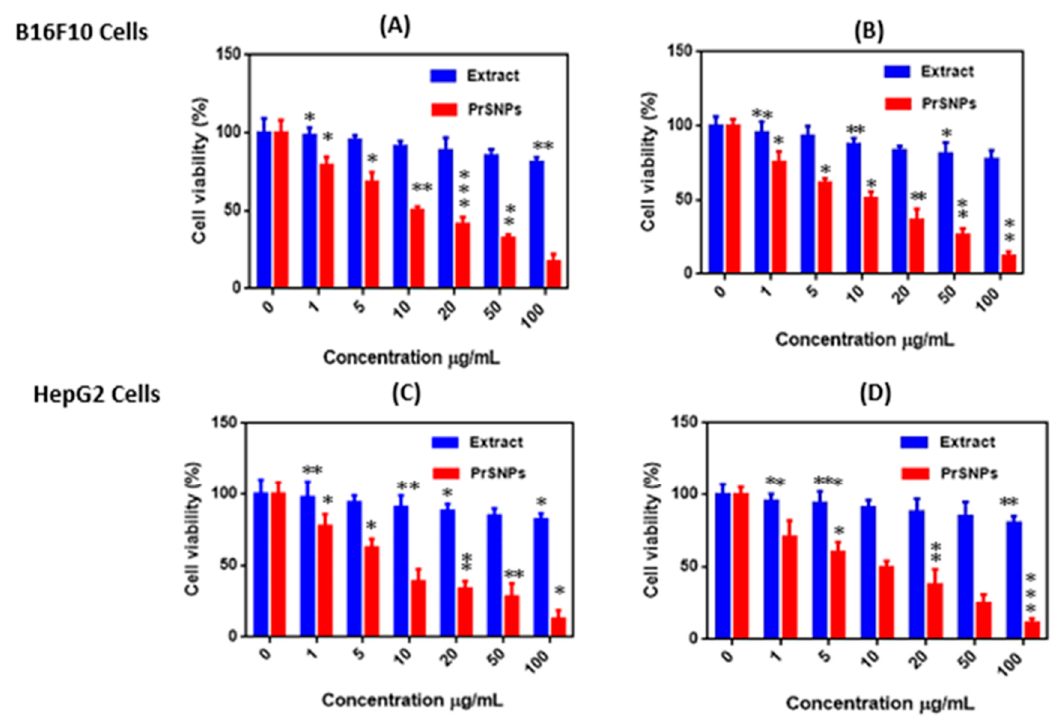
Figure 8. Cytotoxicity assay of PrSNPs against B16F10 cell line after treatment at 24 h ( A ) and 48 h ( B ) and HepG2 cell lines after treatment of 24 h ( C ) and 48 h ( D ) ( n = 3). All experiments performed in triplicate. * p < 0.05, ** p < 0.01 and *** p < 0.001, unpaired Student’s t-test.